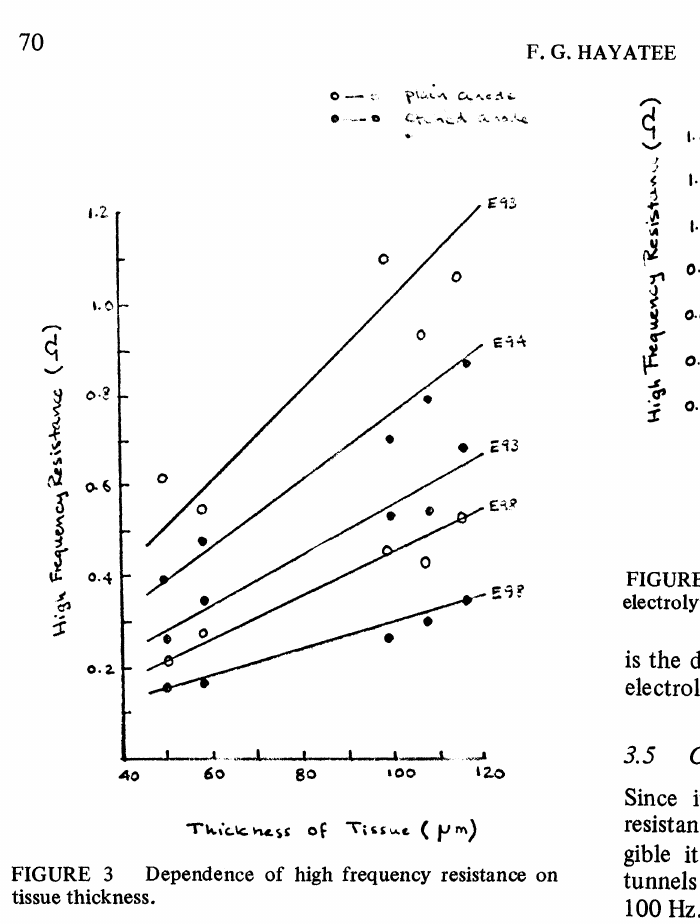
Dependence of high frequency resistance on tissue thickness.